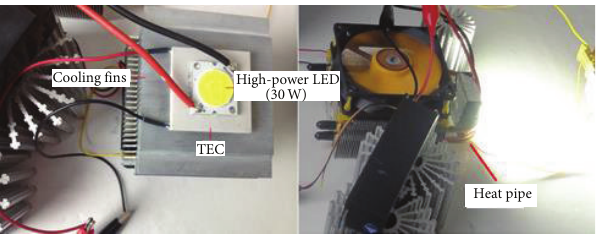
Figure 2: High-power multichip LEDs.